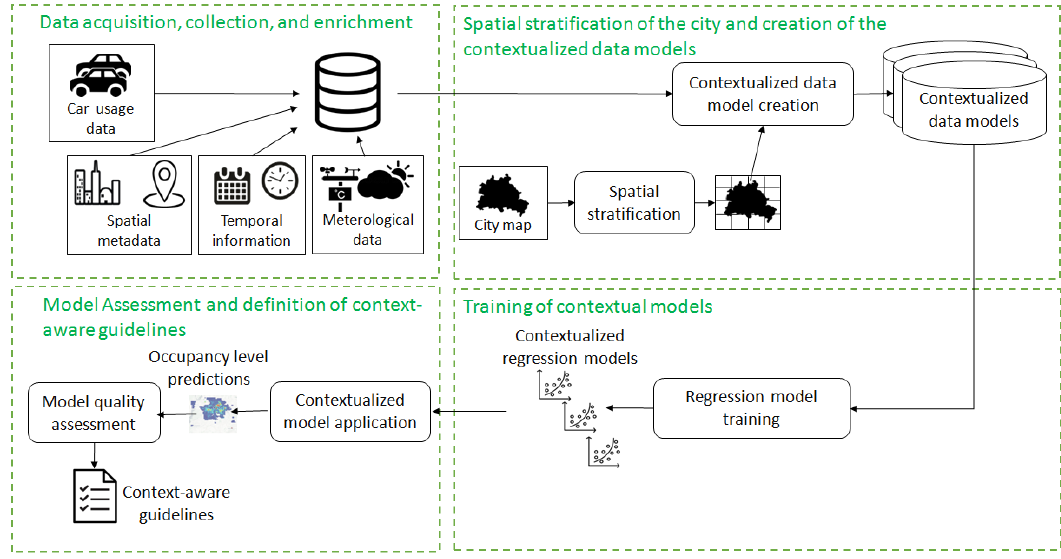
Figure 1. The proposed